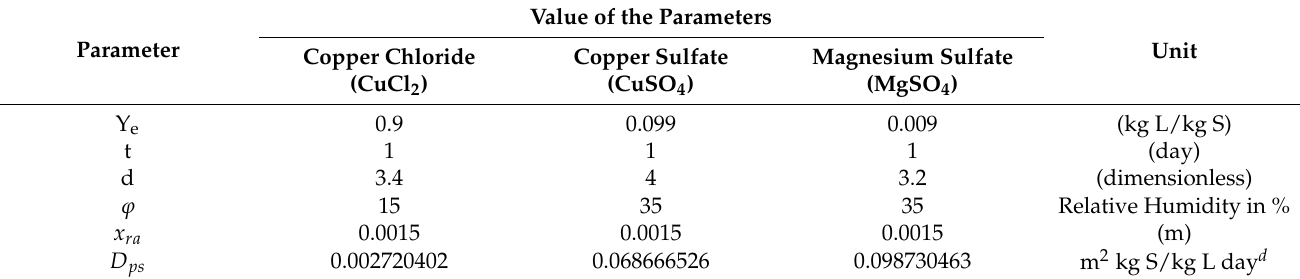
Table 1. The initial data on the static relative humidity (RH) that were used for the current model. Parameter